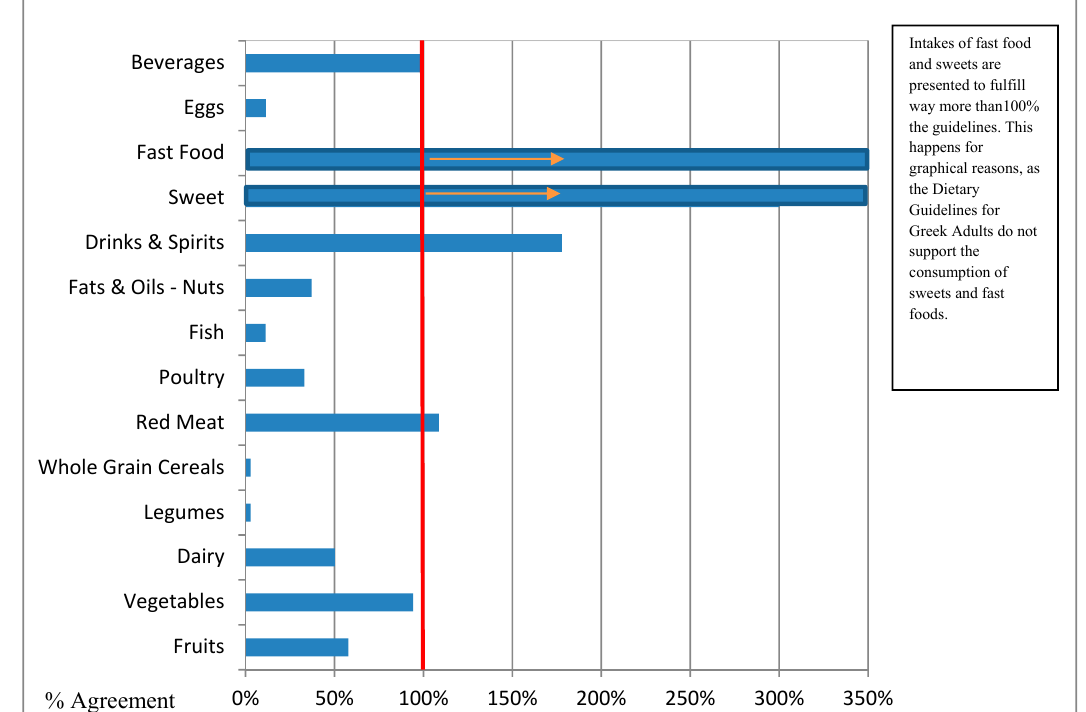
Figure 2. Combined 24 hR with FPQ’s intakes of Greek females and agreement with the Dietary Guidelines for Greek Adults. The percentages of agreement were calculated from the combined intakes (grams/day) of food groups in relation to reported frequency of intake (FPQ) and reported amount of intake (24 hR) of Greek females and the Dietary Guidelines for Greek Adults. The red line represents the point at which guidelines are fulfilled.